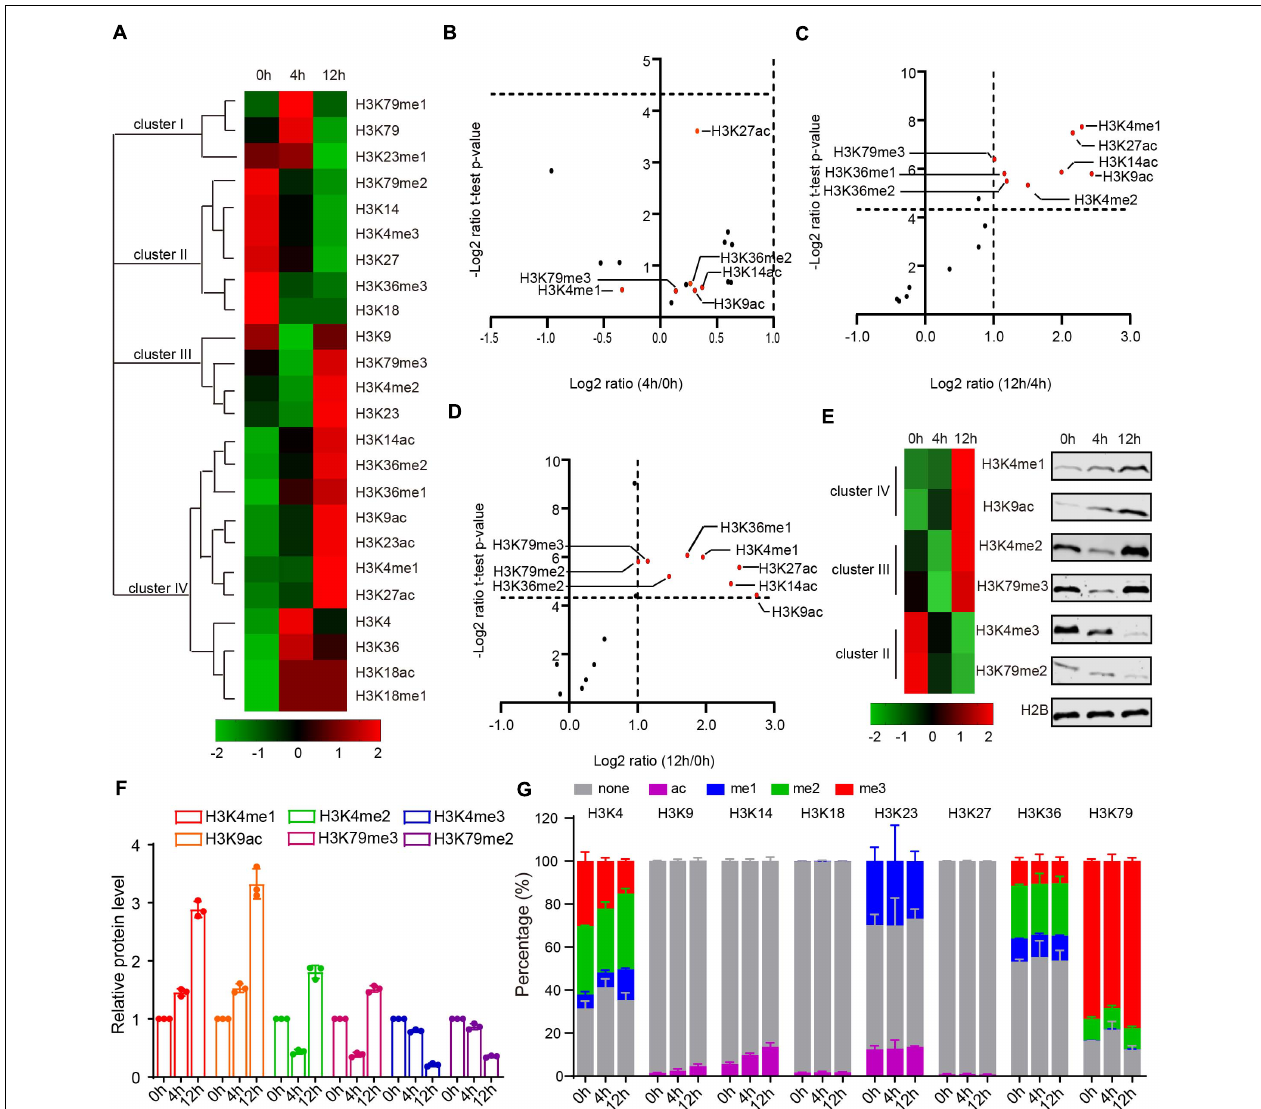
FIGURE 2 | Dynamic changes of yeast histone H3 modifications during sporulation. (A) Hierarchical clustering analysis of histone H3 modifications during yeast sporulation. (B–D) Volcano Plot indicates upregulated and downregulated histone H3 modifications comparing 4 h/0 h, 12 h/4 h, and 12 h/0 h, respectively. In (C,D) , histone H3 modifications with a fold change > 2 and a P- value < 0.05 are shown in red. (E) Western blot verification of MS data. Protein samples for both western blots and MS were extracted from yeast cells using the same methods. (F) Quantitative results of E . The error bars indicate ± SD ( n = 3). (G) Relative abundance of histone modifications at histone H3 lysine sites for yeast MS